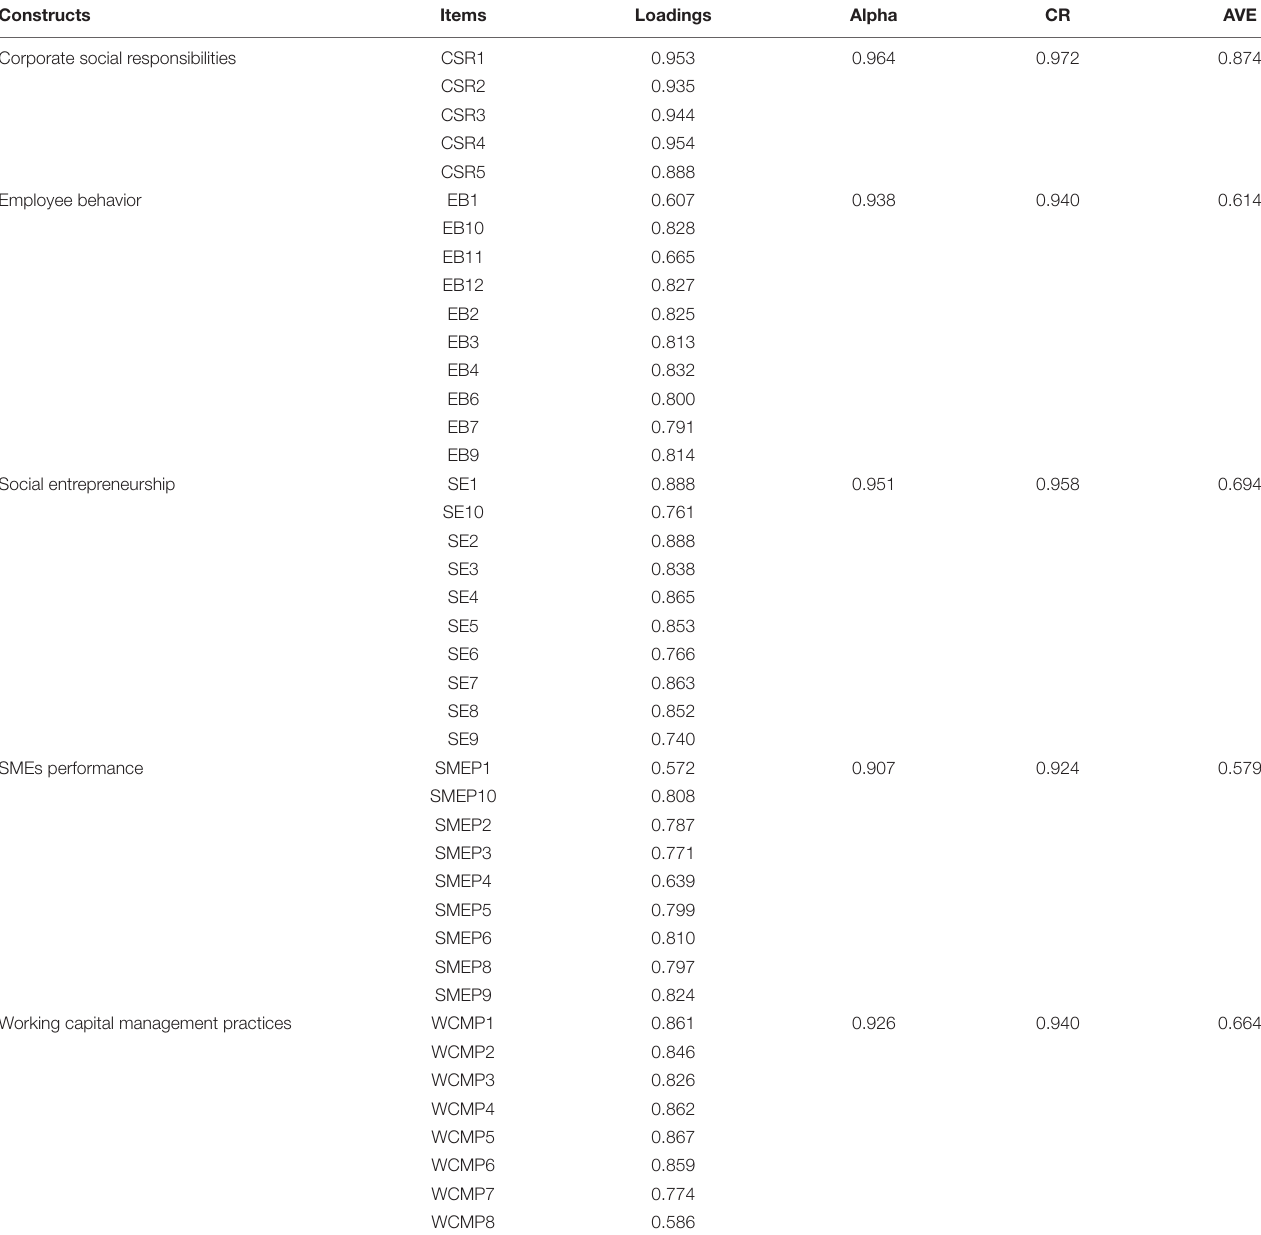
TABLE 2 | Convergent